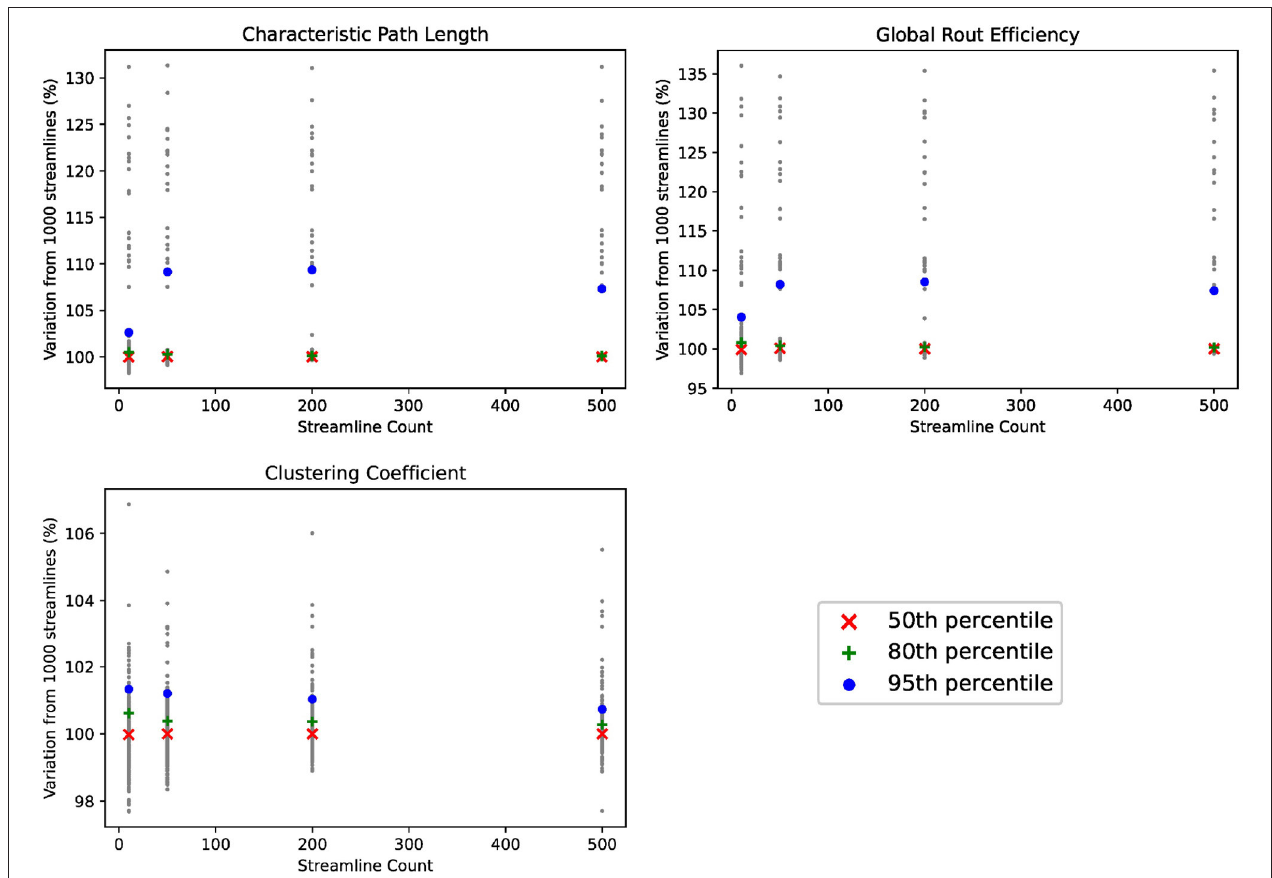
FIGURE 7 | Comparison of graph